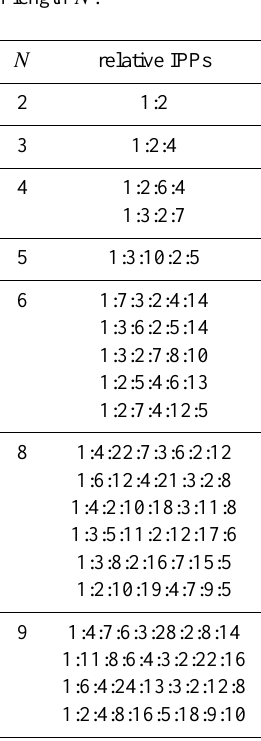
Table 1. Relative lengths of the N inter-pulse periods of simple difference covers of length N .